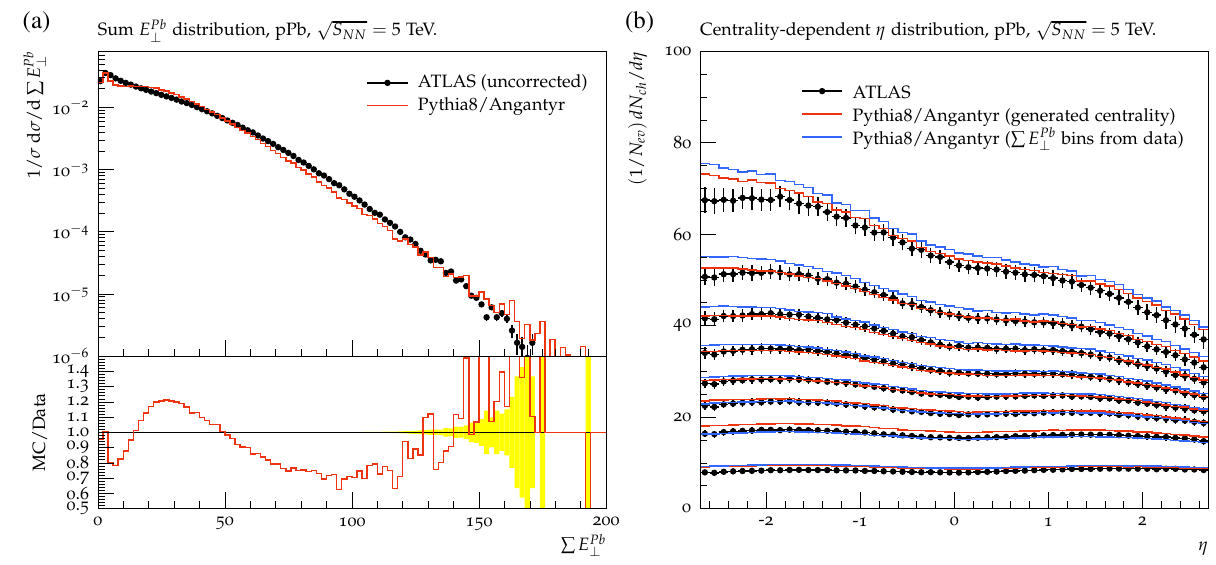
= 5 TeV, as measured 4 . 9 < η < 3 . 2) for pPb collisions at √ s NN − − = 5 TeV as measured data from ATLAS [12] and the results from NN E Pb spectrum, and the blue line according to the experimental ⊥ (cid:31)